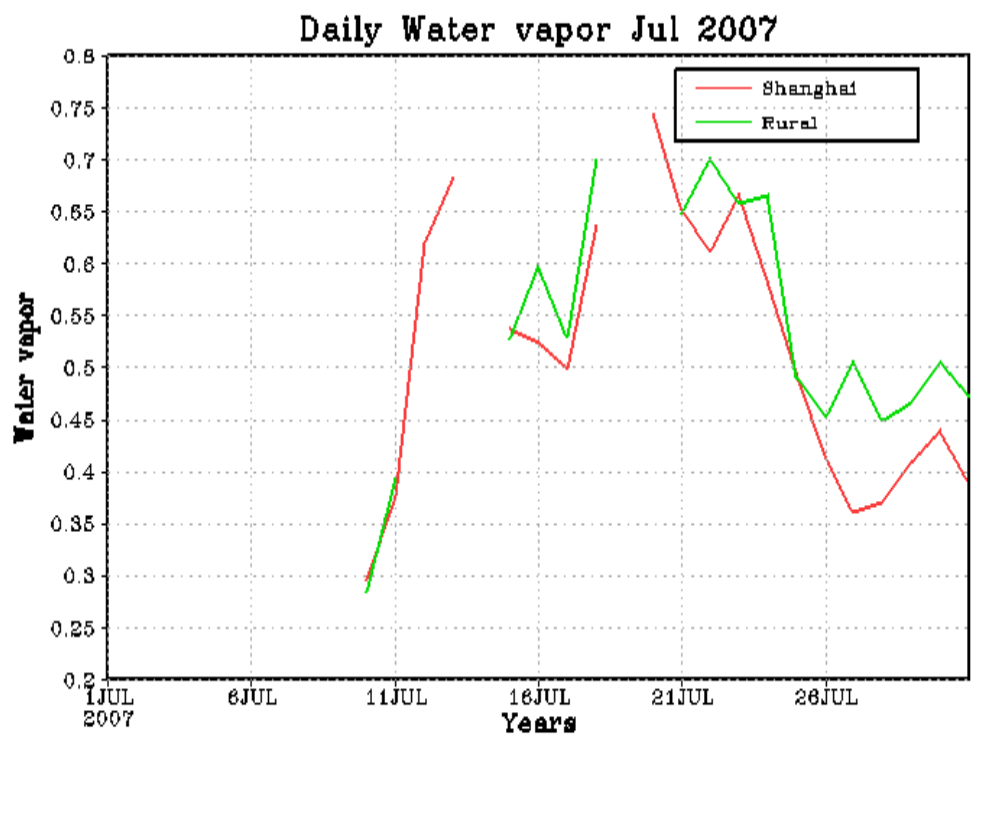
Figure 14. Daily water vapor for July 2007 for Shanghai and rural regions. Due to the cloudy days, only a few days have